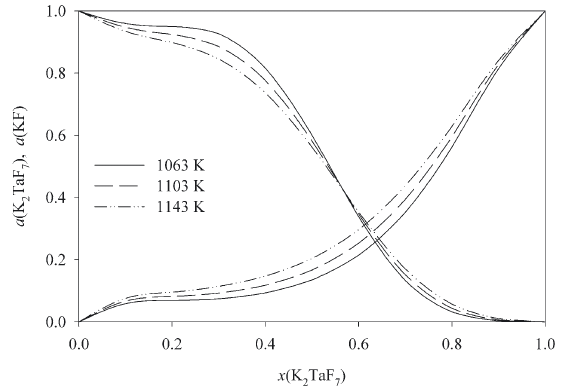
Figure 5. Activities of components in the melt of the system KF–